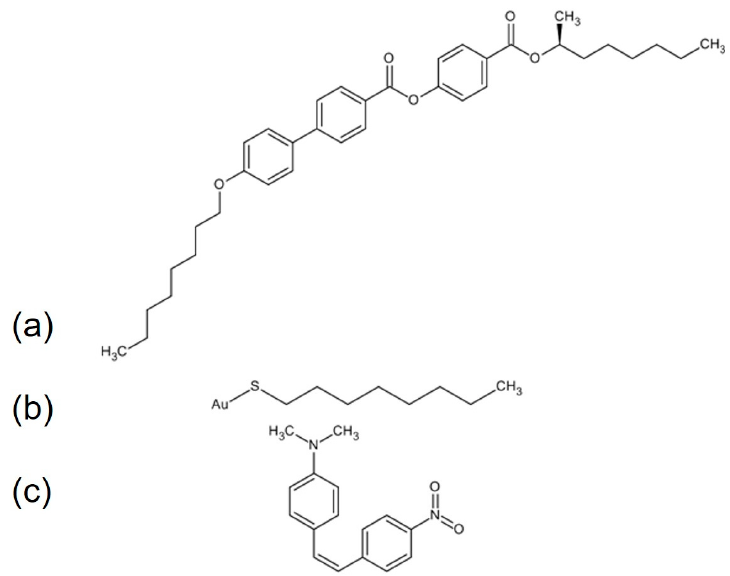
Figure 1. Chemical structure of (S)-MHPOBC ( a ), Au NPs functionalized with 1-octhanethiol ( b ) and dye DANS ( c ).